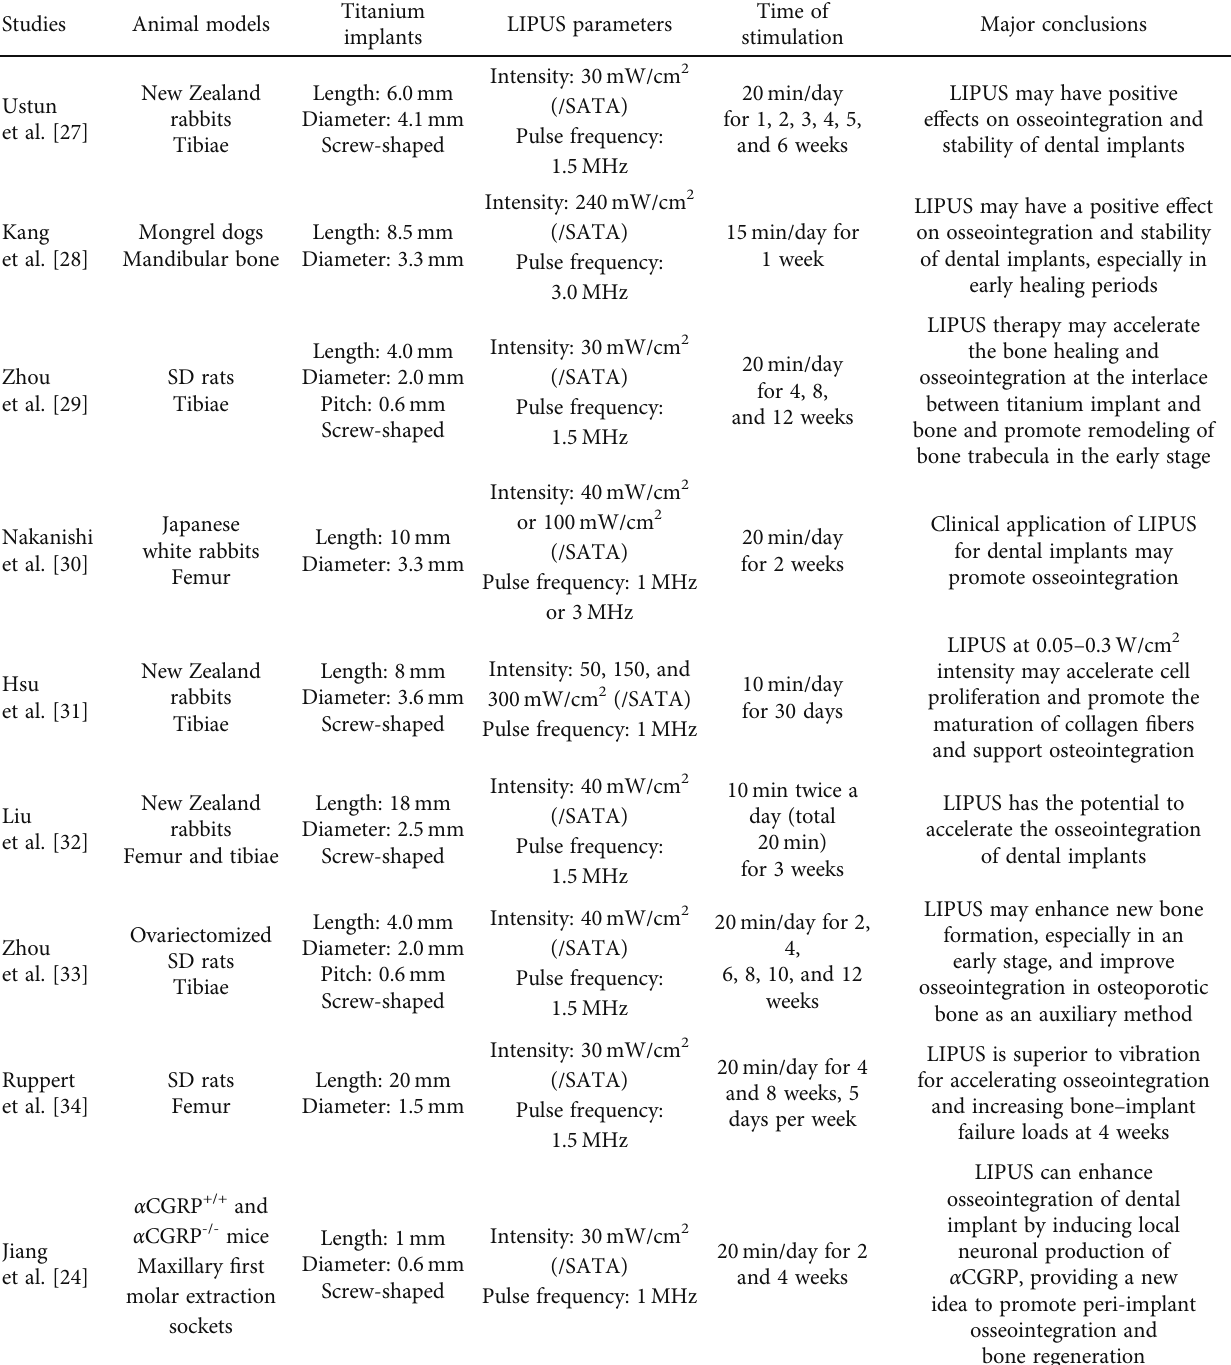
Table 1: Summary of LIPUS studies on implant osseointegration and peri-implant bone